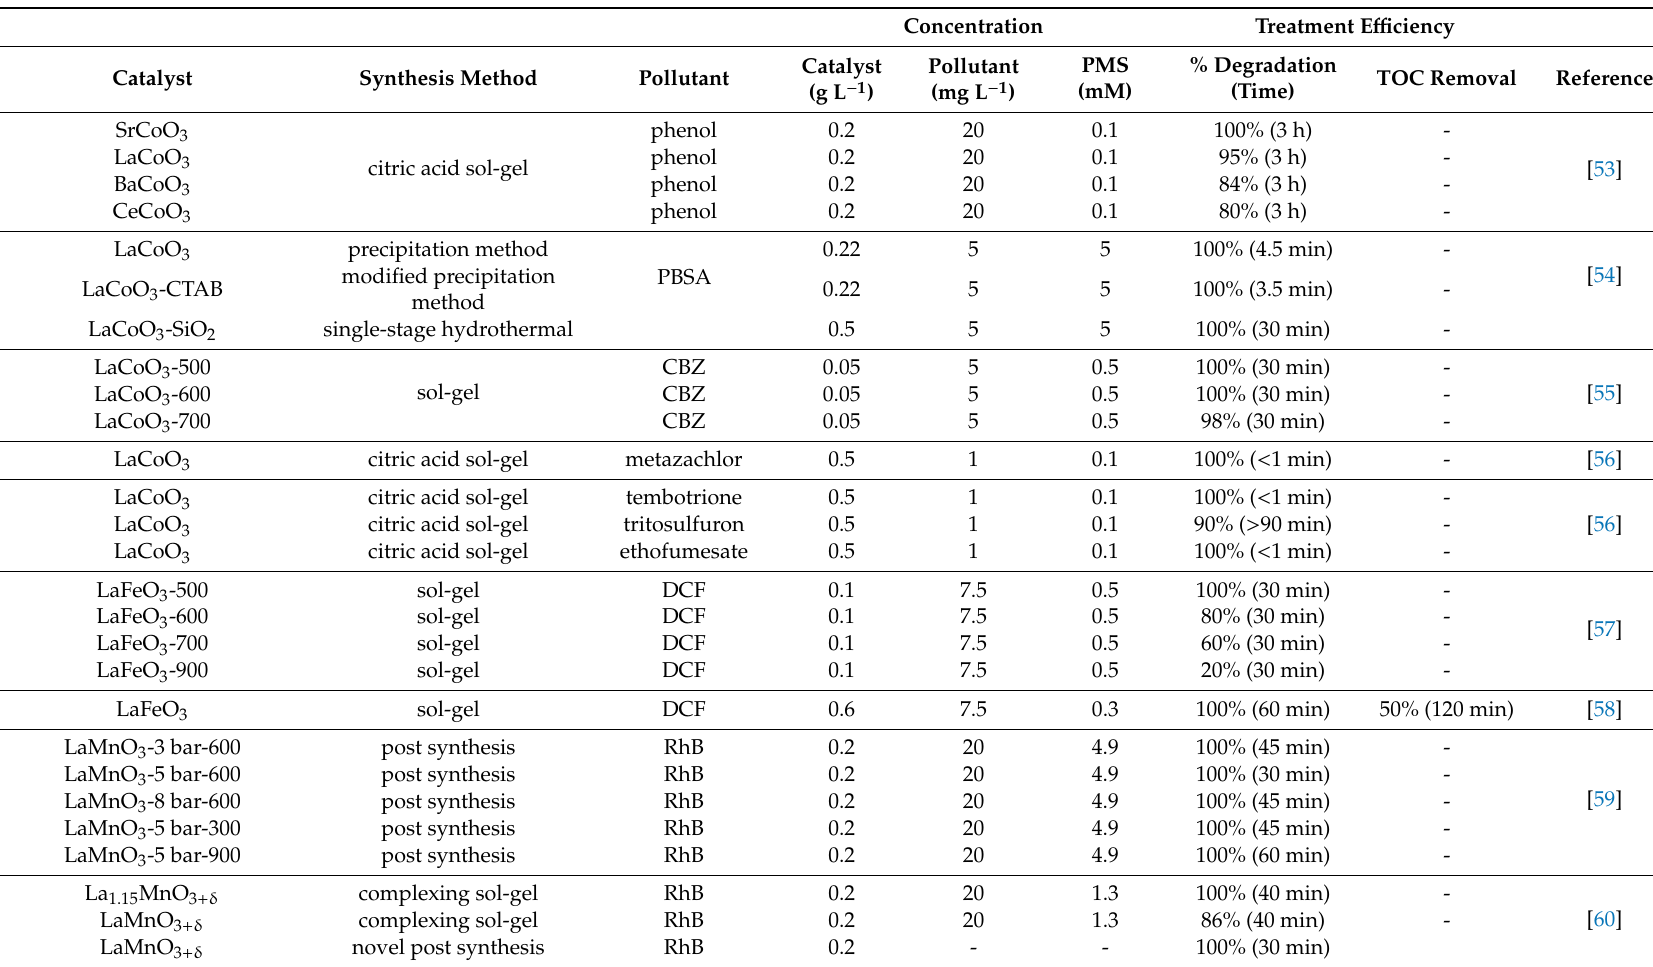
Table 3. Overview of peroxymonosulfate (PMS) activation by di ff erent perovskite catalysts for the degradation of various organic